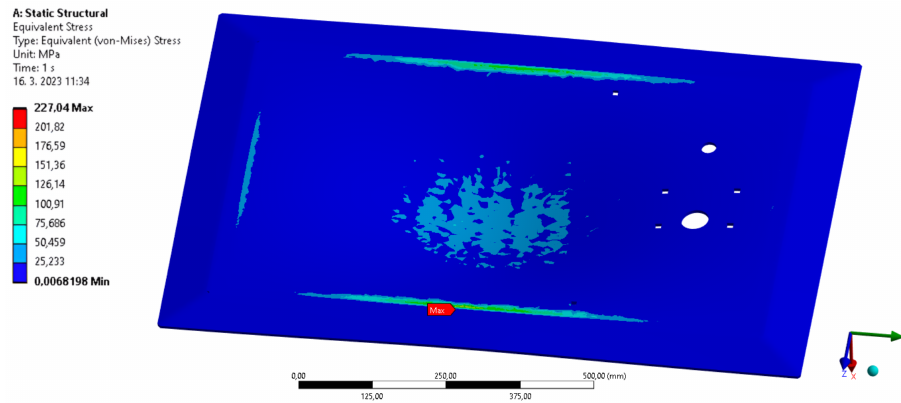
Figure 15. Results of the permanent redesign stress test.